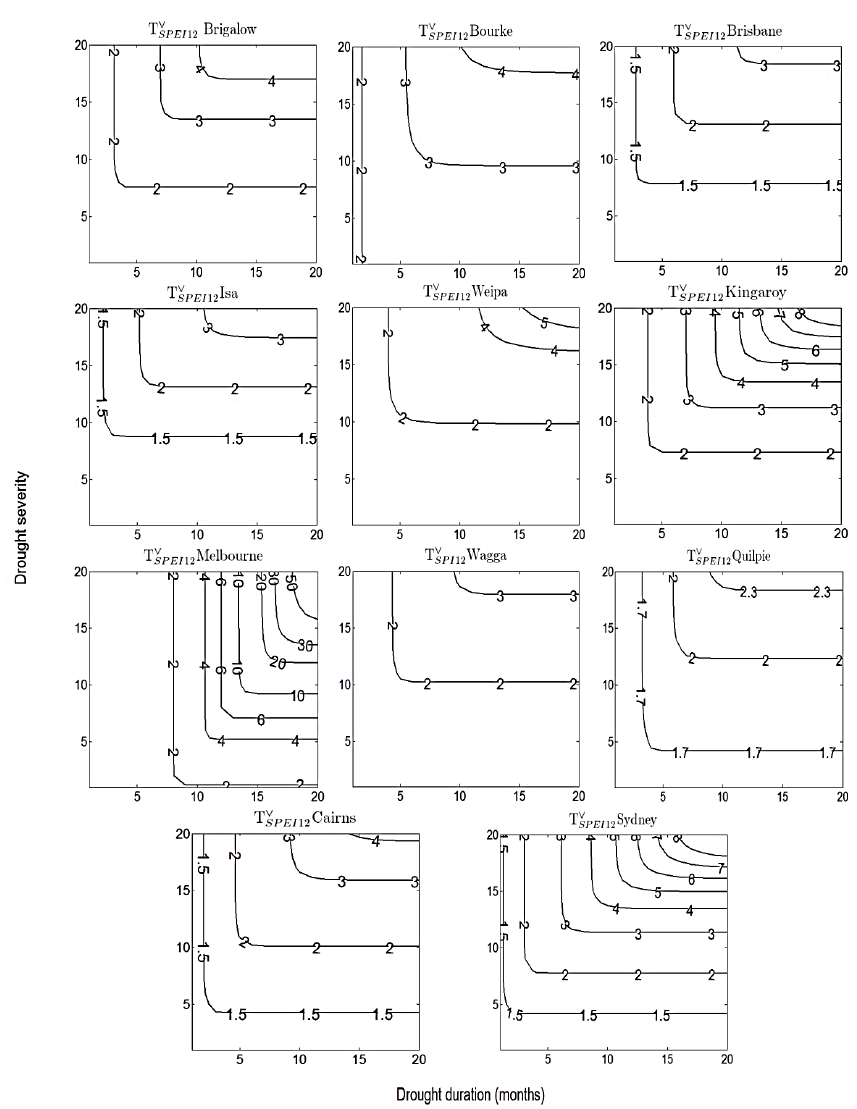
Figure 7. Recurrence interval T ∨ (years) of drought events of any severity or duration of interest based on SPEI 12 (long-term) of historical